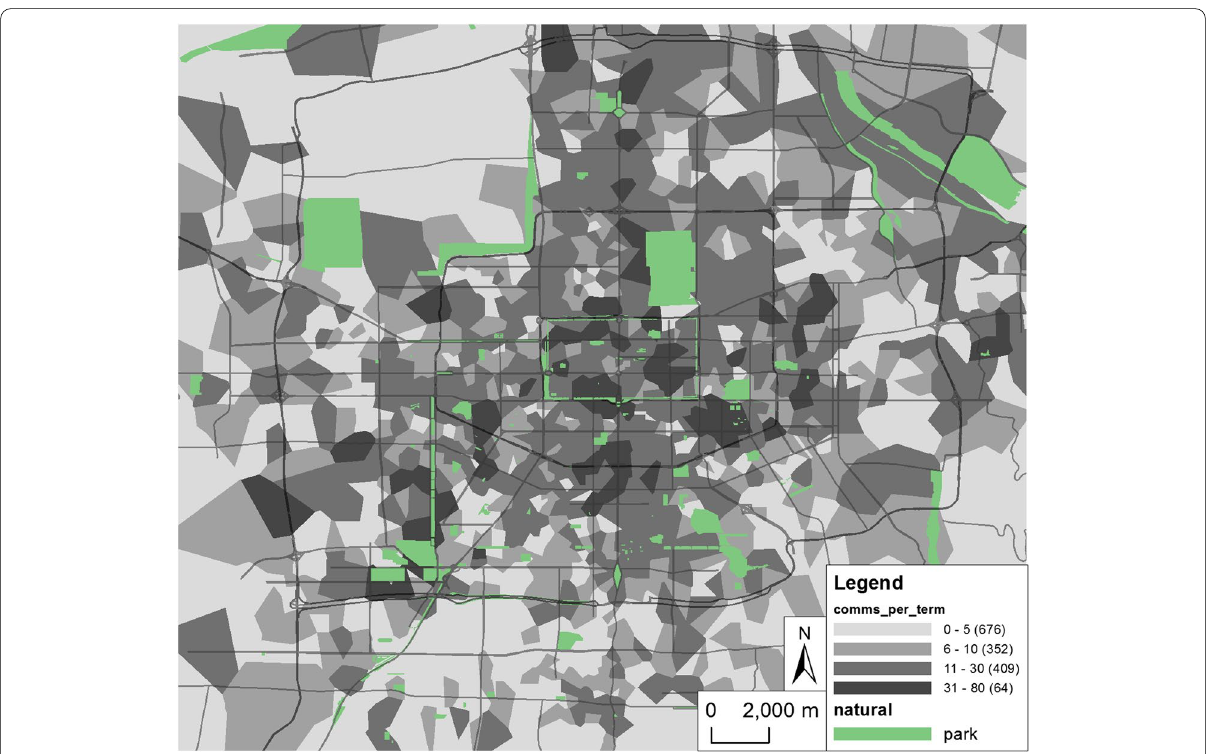
Fig. 5 Service analysis of express logistics terminals to